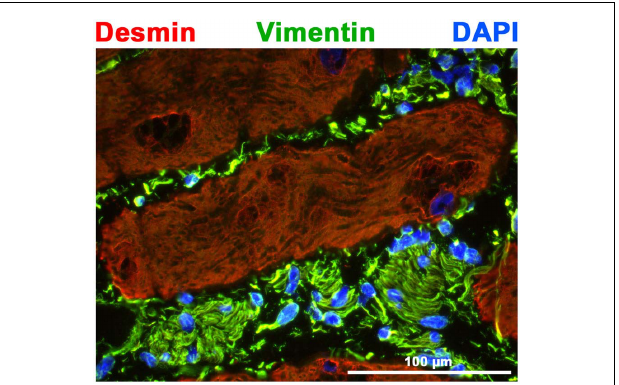
FIGURE 1 | Shown is a cryostat cross-section through ovine Purkinje fibers. Double label immunofluorescence microscopy was performed with antibodies to desmin (red) and vimentin (green) in addition to nuclear DAPI staining (blue). Note that the insulating connective tissue is strongly positive for vimentin, whereas Purkinje fibers are positive for desmin similar to cardiomyocytes of the working myocardium. For experimental details please see Pieperhoff et al. (2010b).